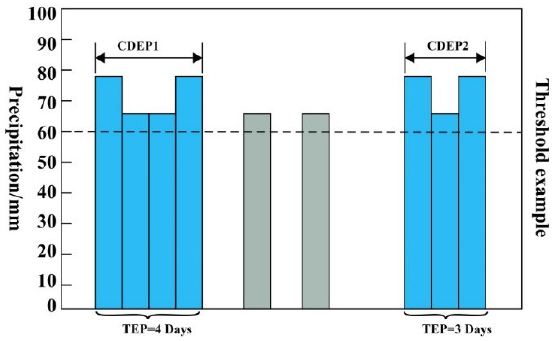
Figure 3. Schematic diagram of flood indicators.